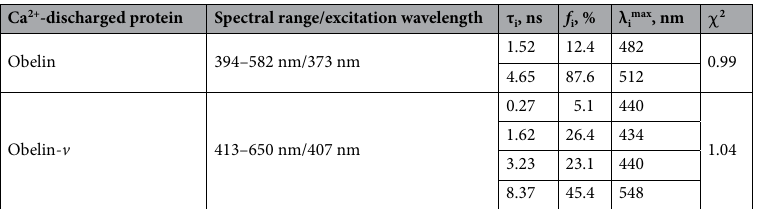
Table 1. Fluorescence lifetime components of Ca 2+ -discharged obelin and obelin- v fluorescence. τ i —lifetime component calculated by global analysis of the decays within indicated spectral range; f i —spectral fraction of the component with τ i in total emission spectrum; λ imax —spectrum maximum, associated with τ i , (DAS i ); χ 2 —statistical criterion characterizing the quality of analysis using indicated lifetime components and their